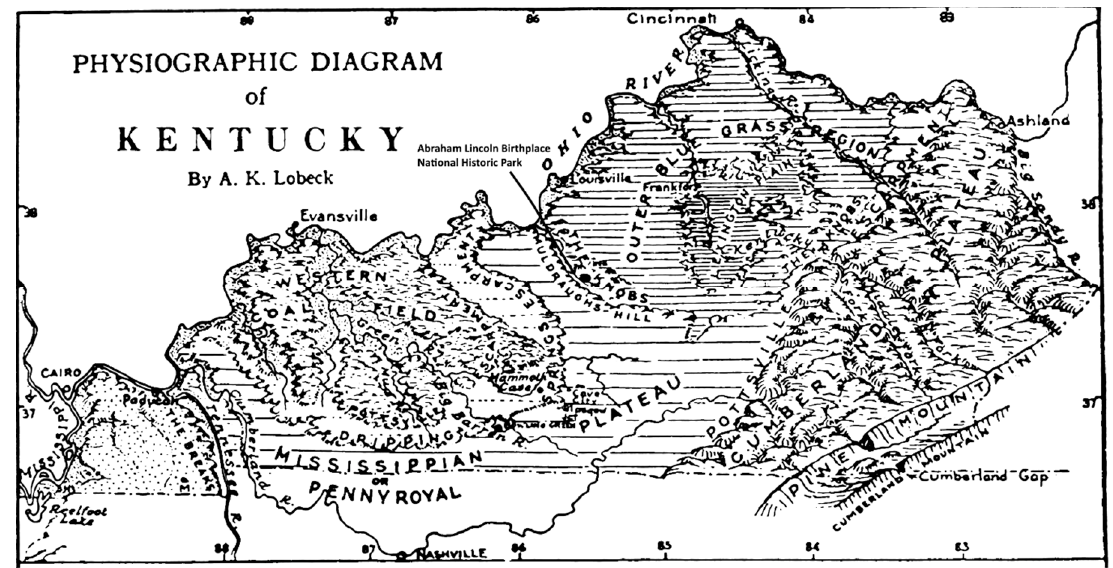
Figure 1. Location of Abraham Lincoln Birthplace National Historical Park in Kentucky, USA from Lobeck 1930.